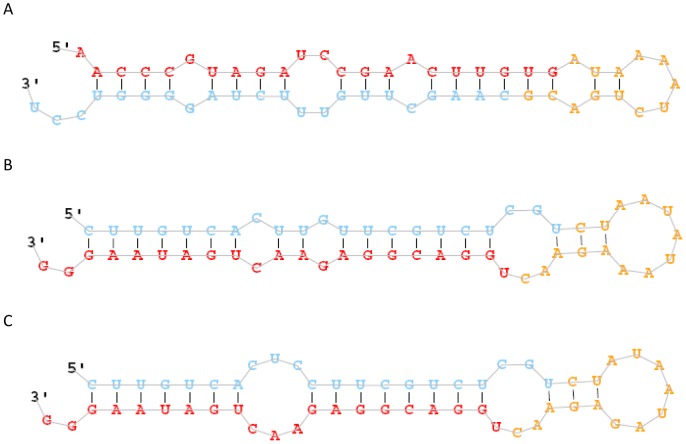
Predicted stem-loop secondary structures of T. granosa coding candidate miRNAs.Folding and free energy calculations were determined with miRDeep2. Dominant forms of the mature miRNAs are indicated in red color (A: Tgr-nmiR-13, B: Tgr-nmiR-32; C:Tgr-nmiR-36).